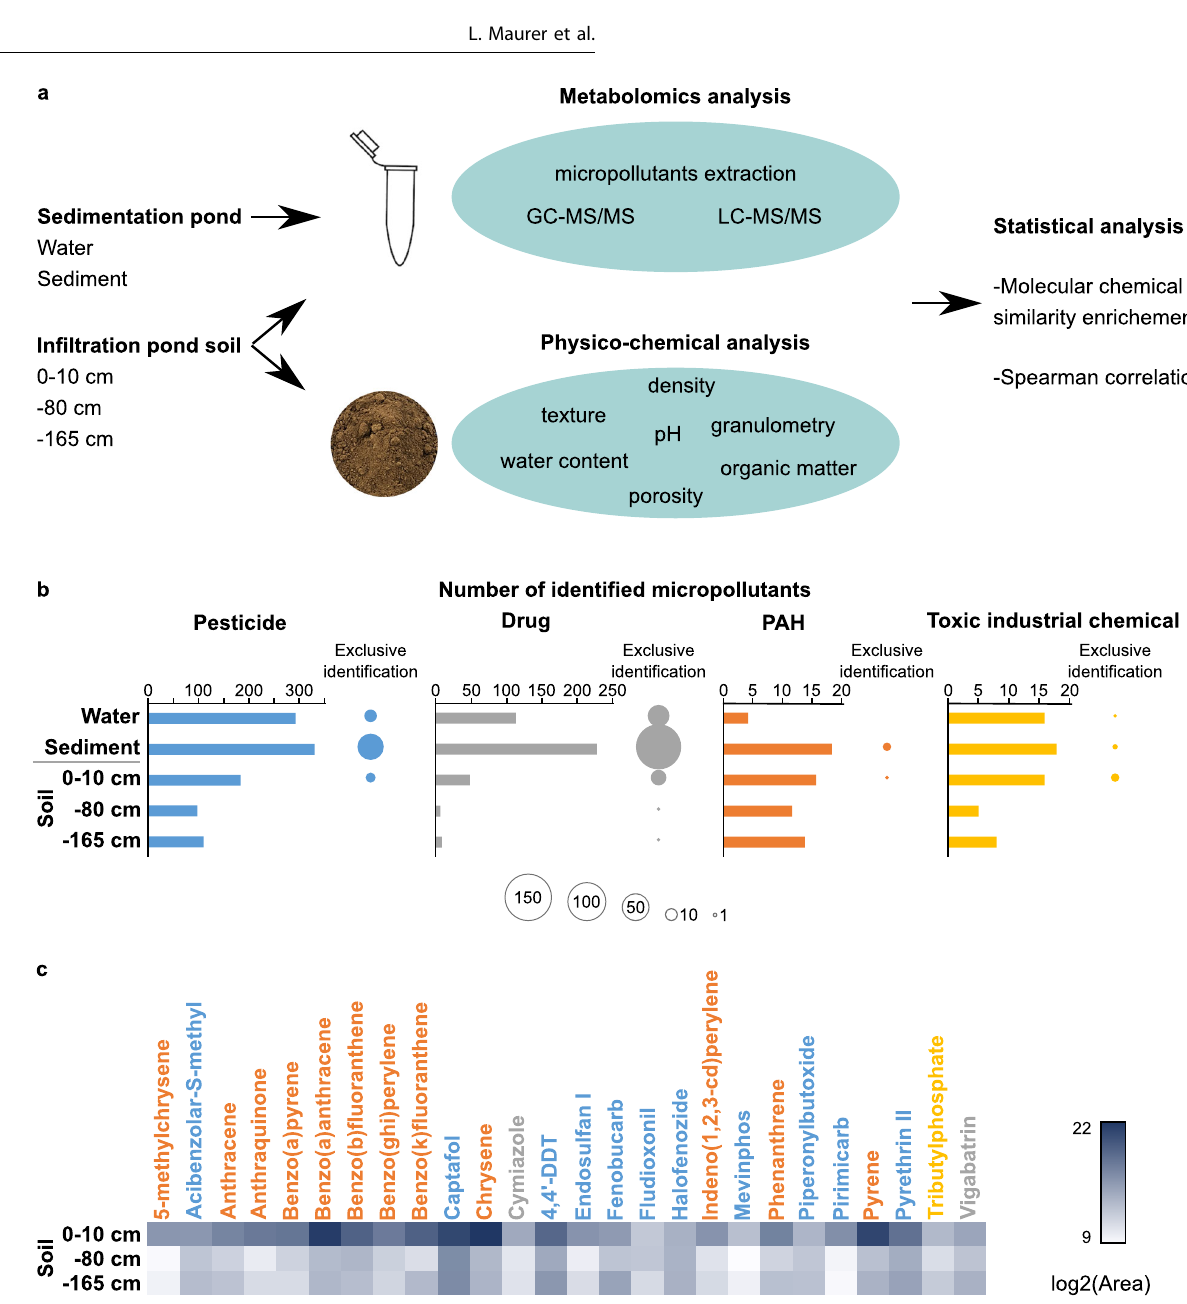
Fig. 1 Distribution of micropollutants in the water, sediment and soil layers. In a fi rst attempt to describe the distribution of micropollutants in the sedimentation pond (water and sediment) and across the soil layers of the in fi ltration pond (from 0 – 10 to − 165 cm in depth), micropollutants were categorized according to their most common usage: pesticide, drug, PAH and toxic industrial chemical were the prevailing categories identi fi ed. a Schematic representation of the study work fl ow. b Number of micropollutants identi fi ed in water, sediment and soil. Exclusive identi fi cations indicate the micropollutants that were identi fi ed exclusively in one type of sample. c Distribution of micropollutants in the different layers of the in fi ltration pond soil presented as log 2 of the peak areas obtained from mass spectrometry